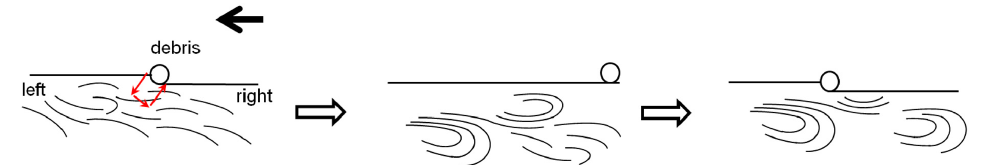
Figure 10. Schematic diagram of the development of the vortex structure.